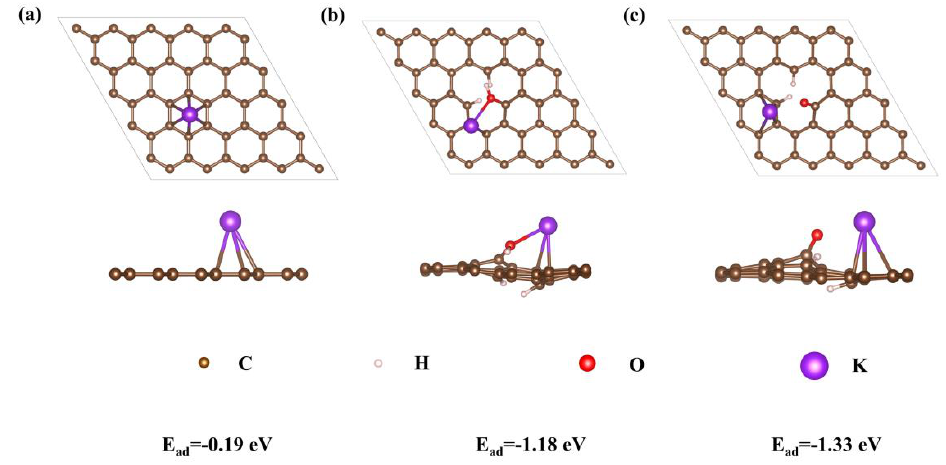
Figure 4. Adsorption of K − ions on ( a ) pure carbon, ( b ) C − O, and ( c ) C=O and the corresponding side views. Brown indicates C atoms, pink indicates H atoms, red indicates O atoms, and purple indicates K atoms. Table 1. Total energy of the species